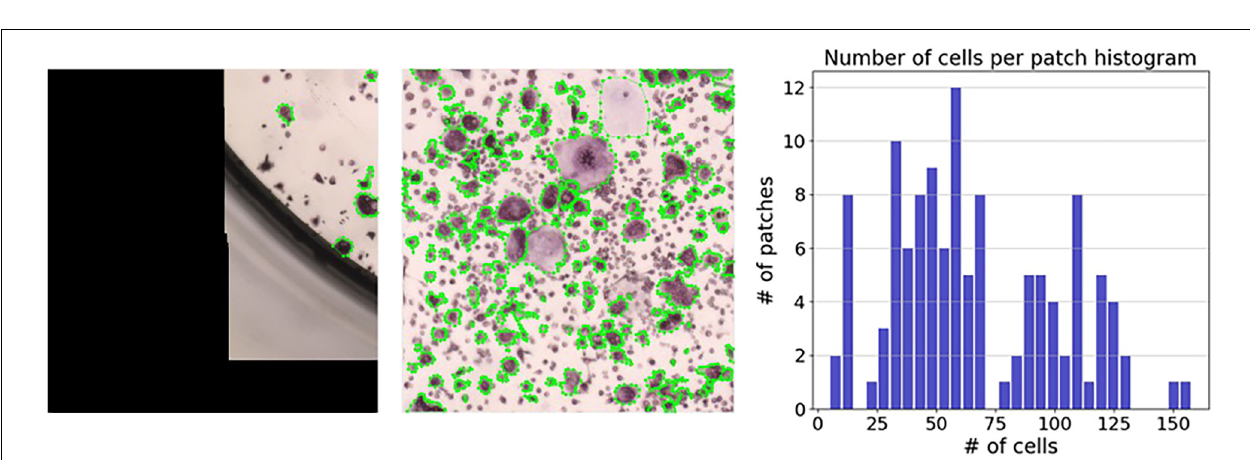
FIGURE 6 | Images of the four different cell types. The first three images depict cells with different number of nuclei. The rightmost cell is a ghost cell.